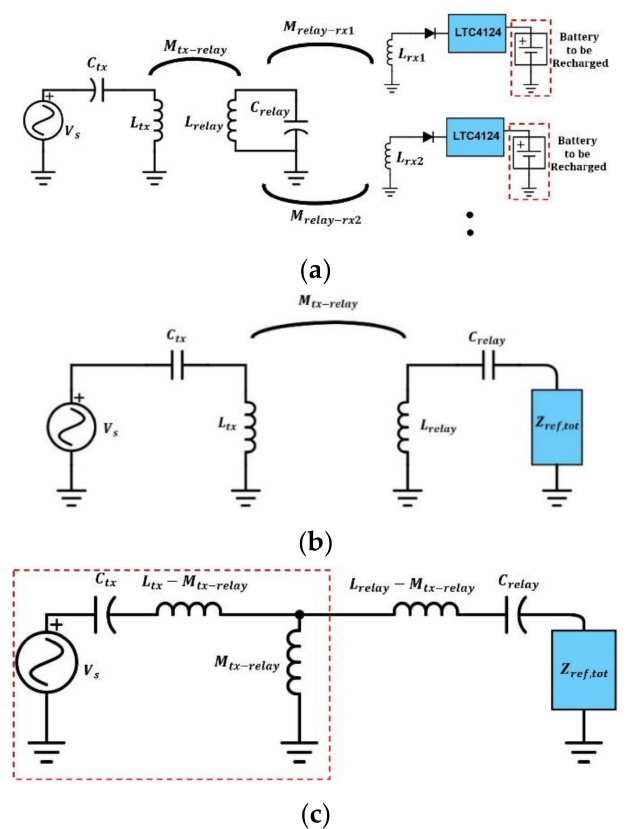
Figure 19. ( a ) Schematic of the wireless-charging drawer system with multiple RXs; ( b ) equivalent circuit model of the wireless-charging drawer system when the coupling between TX and RXs can be neglected; ( c ) equivalent circuit model with coil pair in ( b ) replaced with